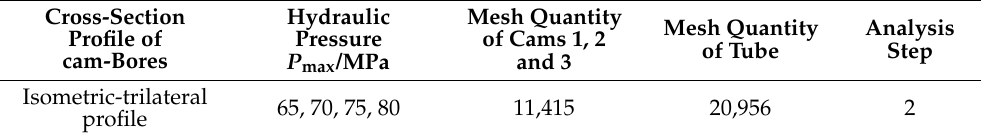
Table 6. Relevant parameters of isometric-trilateral profile in ABAQUS 6.14